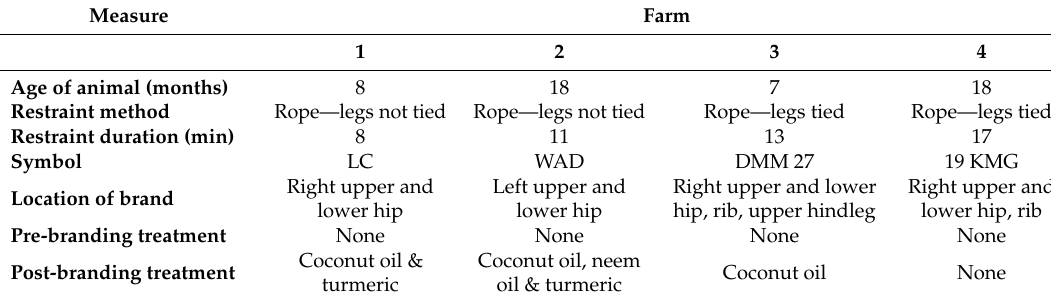
Table 1. Record of hot-iron branding practices on four smallholder farms in Kantale, Eastern Province, Sri